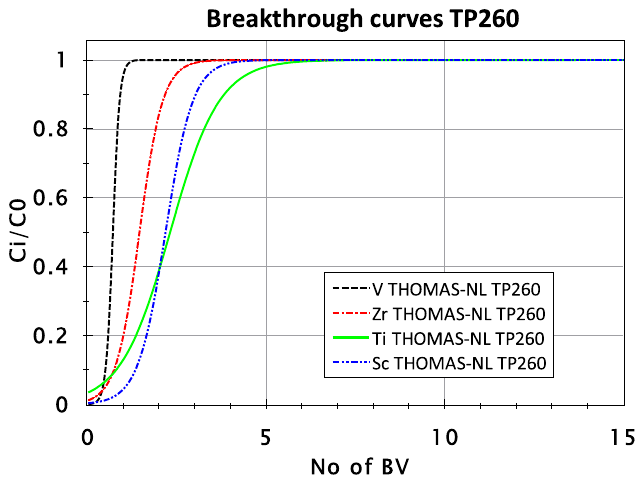
Figure 5. The comparative breakthrough curve for the metals of interest for TP 260 resin according to Thomas nonlinear (NL) prediction mathematical model.